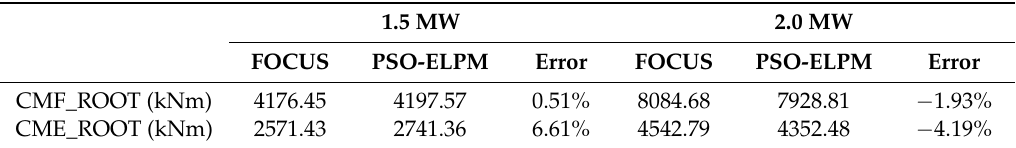
Table 1. The extreme values of CMF_ROOT and CME_ROOT.